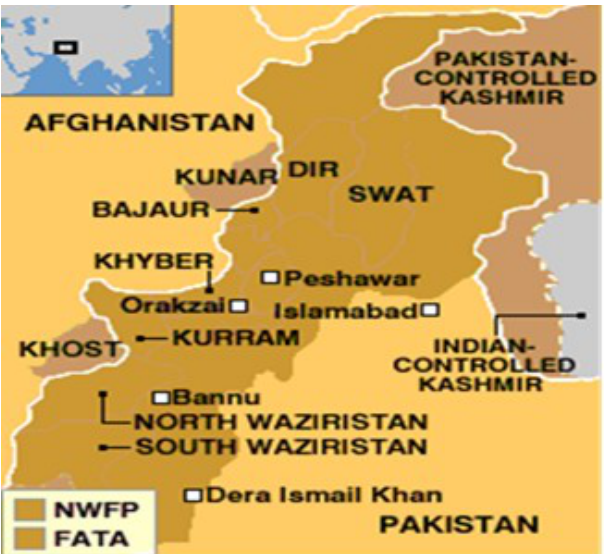
Figure 1. Location of Bajaur area. It is very close to the Afghanistan border near the famous Kunar